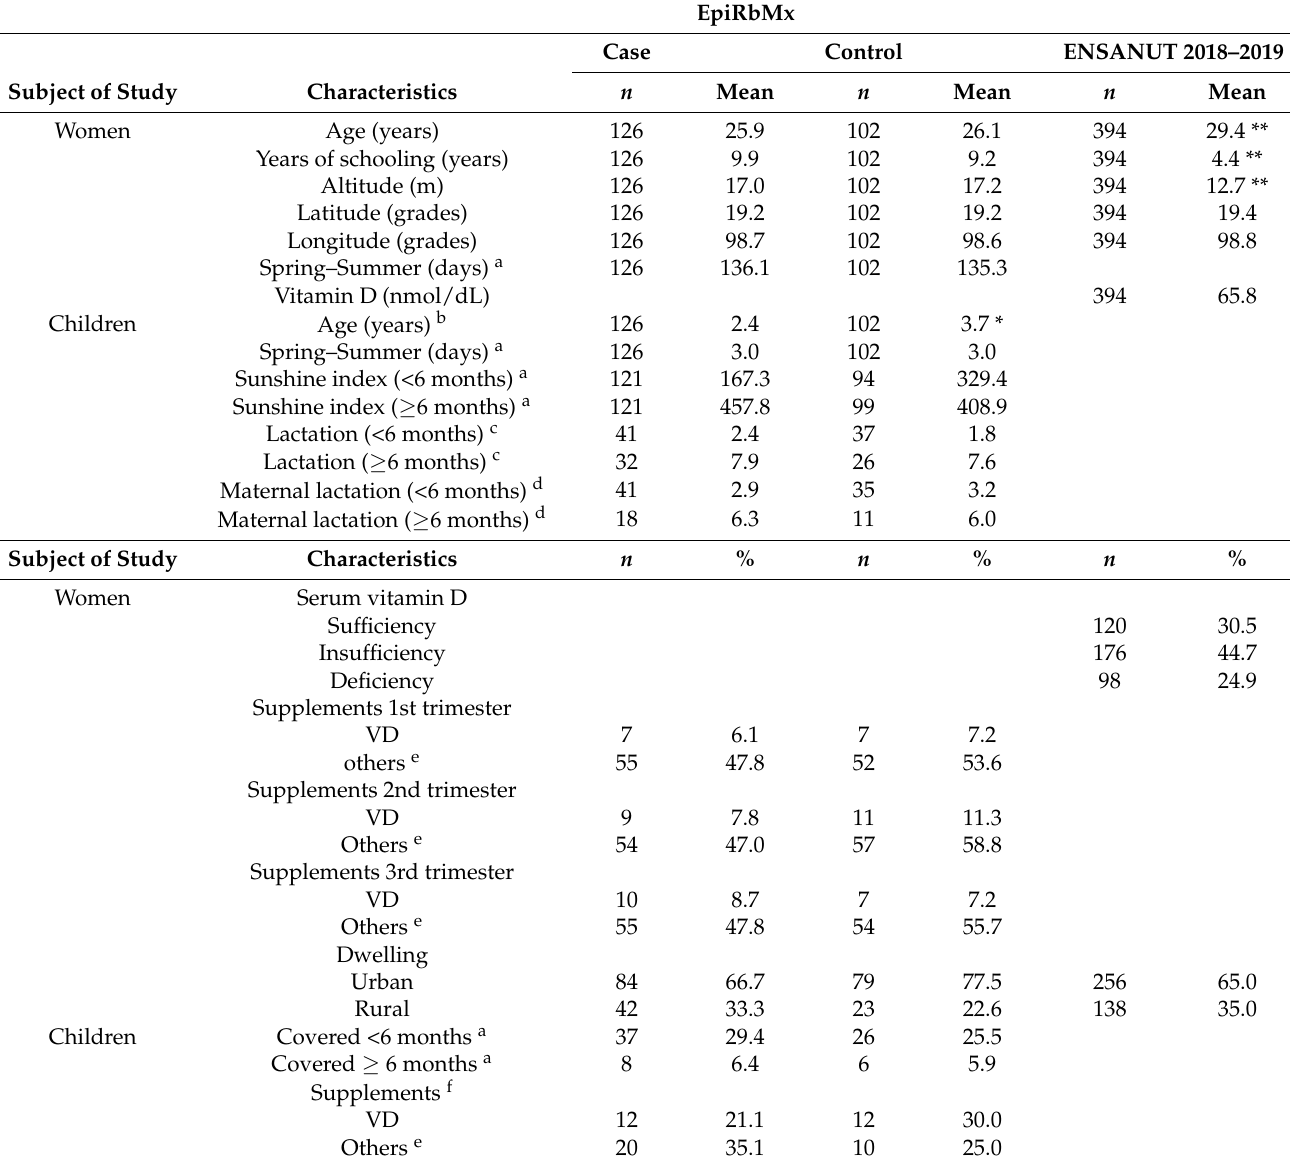
Table 1. Characteristics of women and children of EpiRbMx and ENSANUT